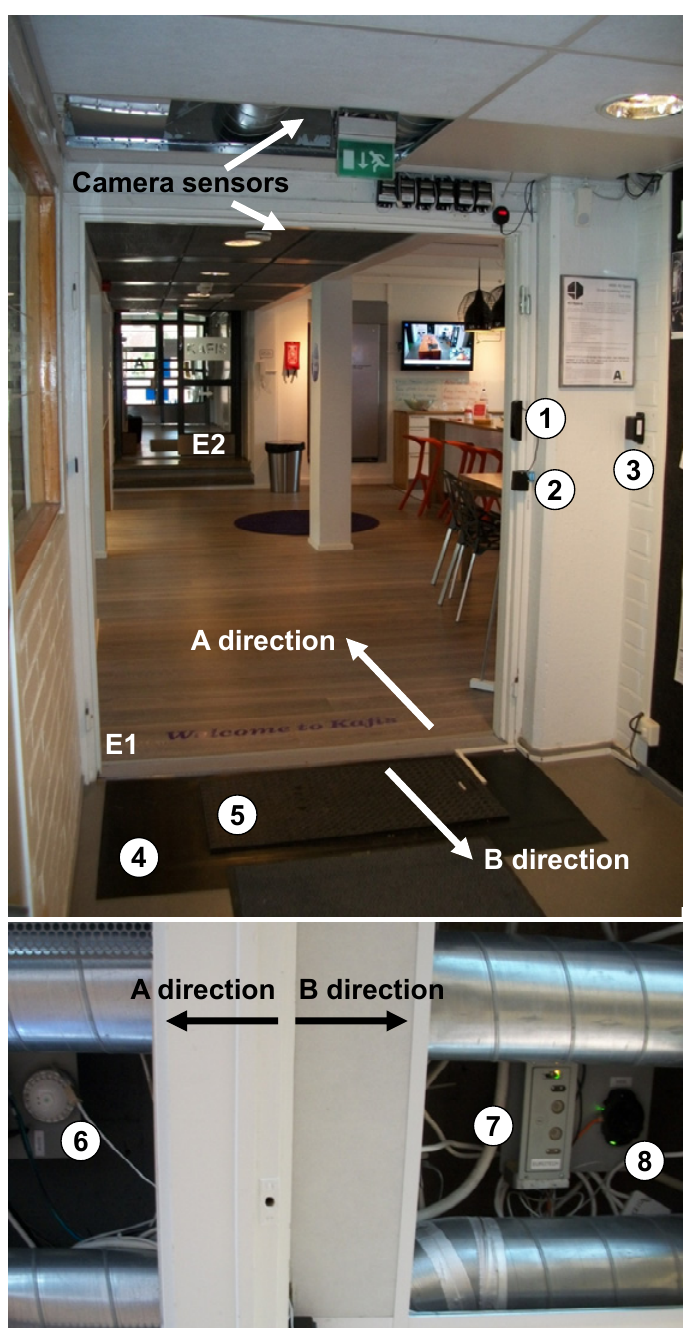
Figure 1. Test site as seen from the corridor side with the counting directions and the light beam and mat sensors (above) and the placement of the camera sensors on the ceiling at both sides of the test site doorway (below). The test sensors: ( 1 ) triangulation proximity switch; ( 2 ) IR photocell with reflector; ( 3 ) background suppression sensor; ( 4 ) piezoelectric mat; ( 5 ) switching mat; ( 6 ) thermal camera; ( 7 ) stereoscopic camera and ( 8 ) network camera. E1 and E2 represent the two entrances of the Café